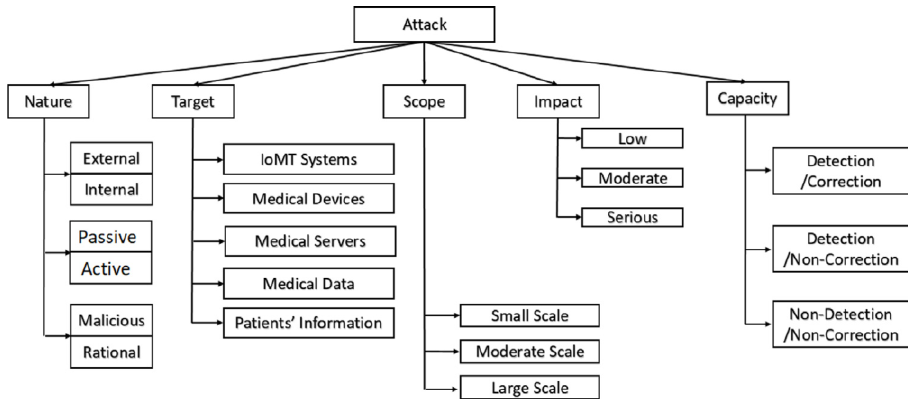
Figure 34. Characteristics and profiles of attackers and its corresponding impact [114]. Abbreviations used: IoMT, Internet of Medical Things. Reprinted with permission from ref. [114]. 2020 Elsevier.